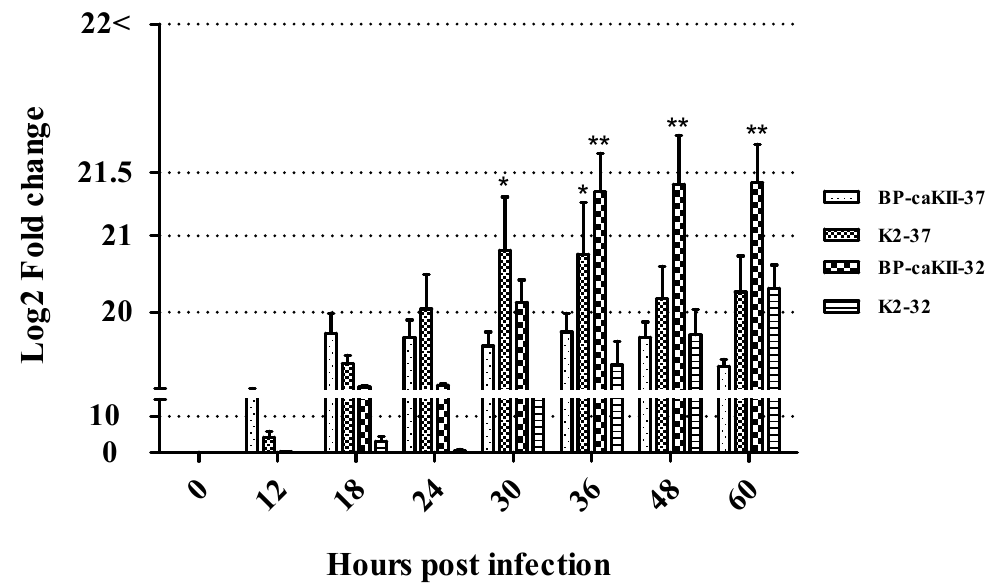
Figure 1. The growth increment of BP-caKII and K2 in embryonated eggs at 32 °C and 37 °C, over time (hour, h). The time point and the mean fold change of RNA copy (log2) were represented on the x - and the y -axis, respectively. Fold changes were calculated by multiplying the ddCt value and real fold-change of each virus calculated from regression analysis. * Significant difference of K2-37 °C from BP-caKII-37 °C and K2-32 °C; ** significant difference of BP-caKII-32 °C from others ( p < 0.05).